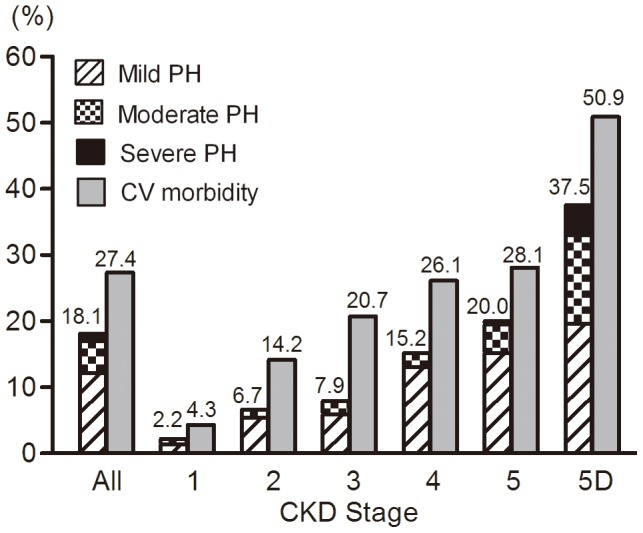
Prevalence of PH and CV morbidity in different CKD stages.Prevalence of both PH and CV morbidity increased gradually with progression of renal function, and reached a peak point when hemodialysis (CKD-5D) initiated. PH patients were mostly mild to moderate PH.